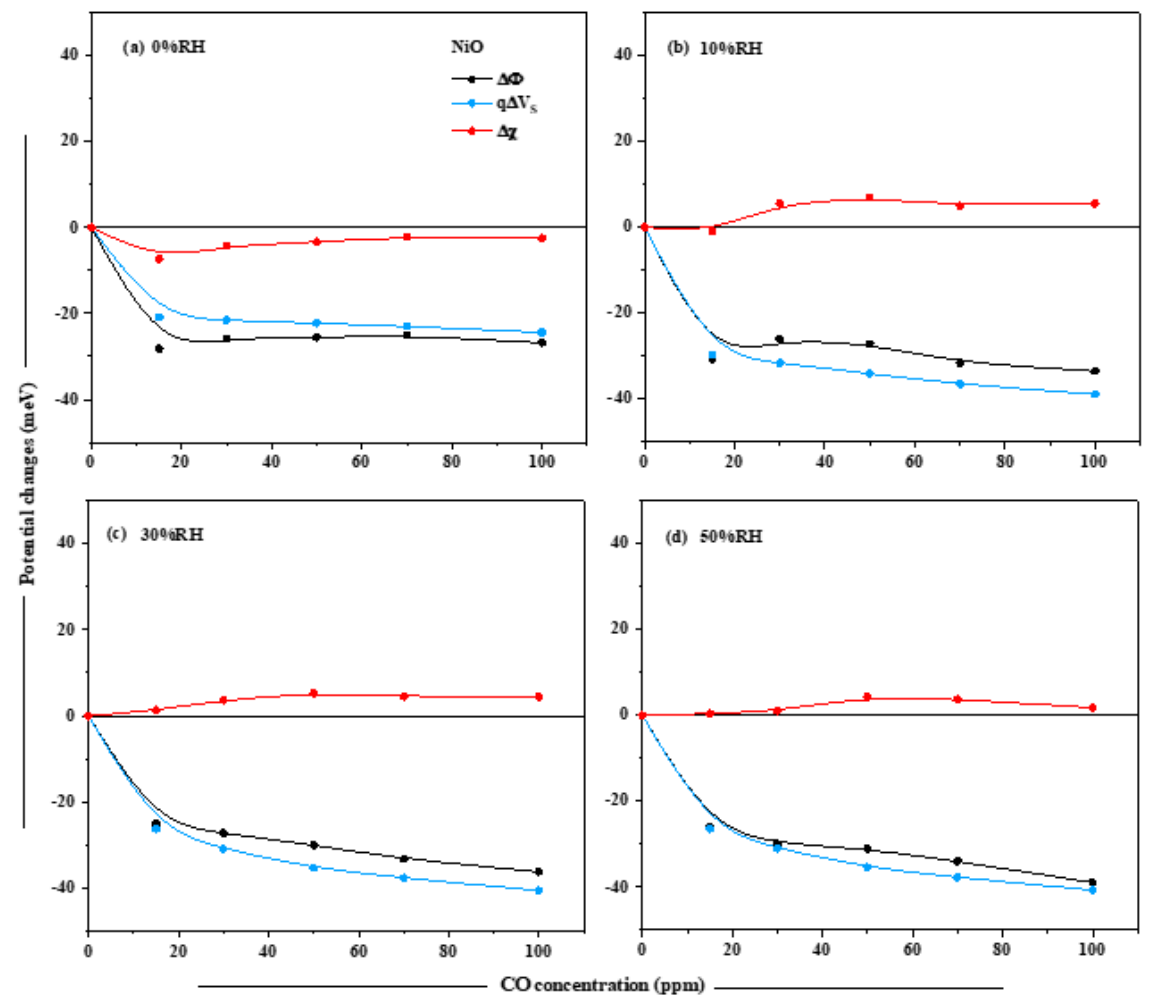
Figure 7. Dependence of the potential changes with respect to CO concentration for NiO-based gas sensor operated at 250 °C and different background humidity: 0%RH ( a ); 10%RH ( b ); 30%RH ( c ); 50%RH ( d ).